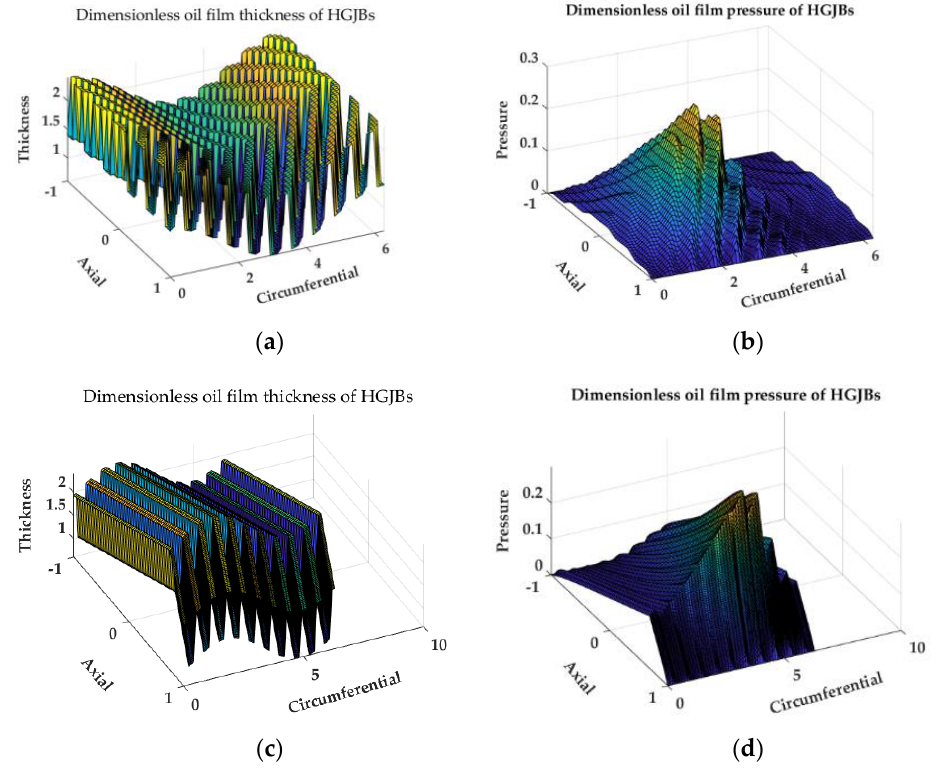
Figure 12. Comparison of calculation results in different coordinate systems: ( a ) Thickness distribution in Cartesian coordinate system ( b ) Pressure distribution in Cartesian coordinate system ( c ) Thickness distribution in oblique coordinate system ( d ) Pressure distribution in oblique coordinate system.